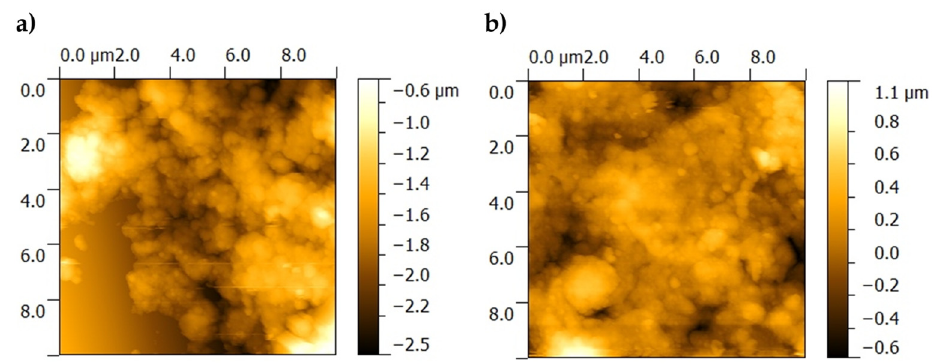
Figure 4. AFM images of as-deposited film surface, at two different locations on the sample. ( a ) BG+CIPRO/PMMA_1 and ( b ) BG+CIPRO/PMMA_2.